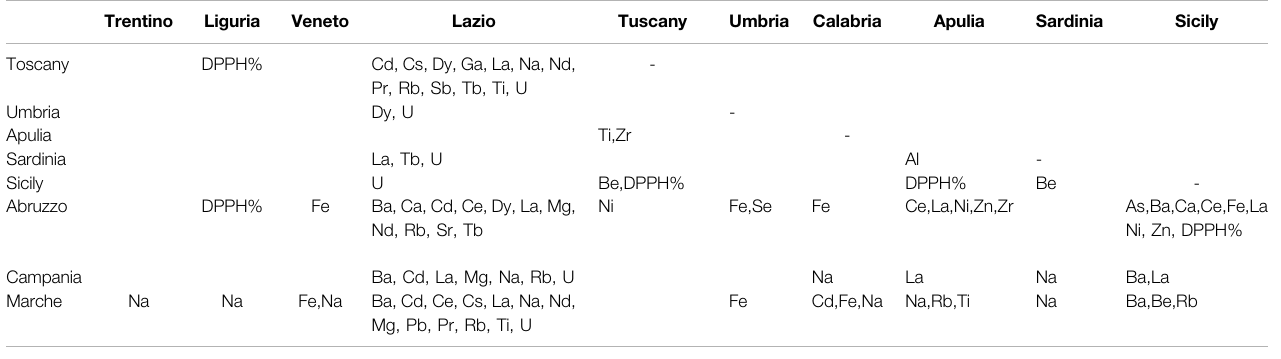
TABLE 4 | Summary of signi fi cant differences within medians of the 45 selected elements and antioxidant activity (DPPH%) among all samples from Italian regions by Kruskall – Wallis and pairwise post-hoc tests. A p -value lower than 0.05 was considered statistically signi fi cant. Trentino